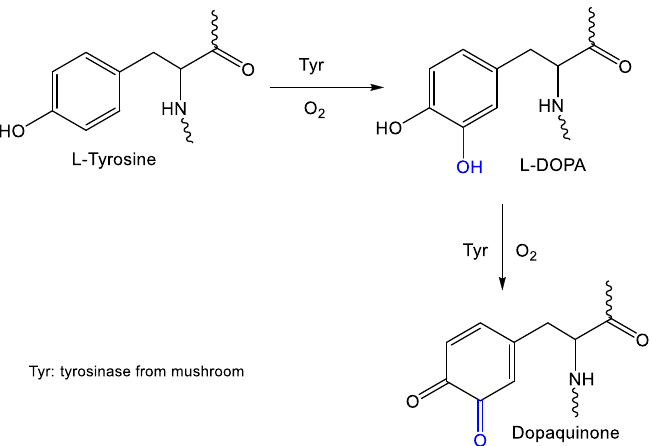
Figure 6. Proposal enzymatic activity capacity of tyrosinase from mushroom A. bisporus by selective oxidation of tyrosine residues.